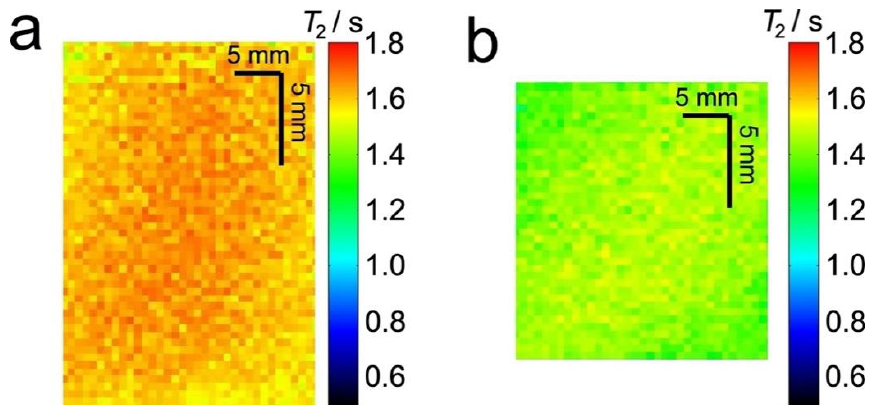
Figure 4. Extracted sections from 2D 1 H MR T 2 relaxation maps of 7° dH water in an uncompressed ( a ) and 60% compressed ( b ) sponge plug. Both images are for the same plug. Figure 5 compares the distributions of maximum opening (Figure 5a), determined by X-ray µCT, and T 2 relaxation times (Figure 5b,c), determined from MRI and bulk NMR measurements, for the same uncompressed and 60% compressed plug. All three distributions indicate an average smaller maximum opening and shorter T 2 relaxation time for compressed sponge plugs compared to uncompressed plugs. The average maximum opening and T 2 relaxation times for these distributions are given in Table 2.